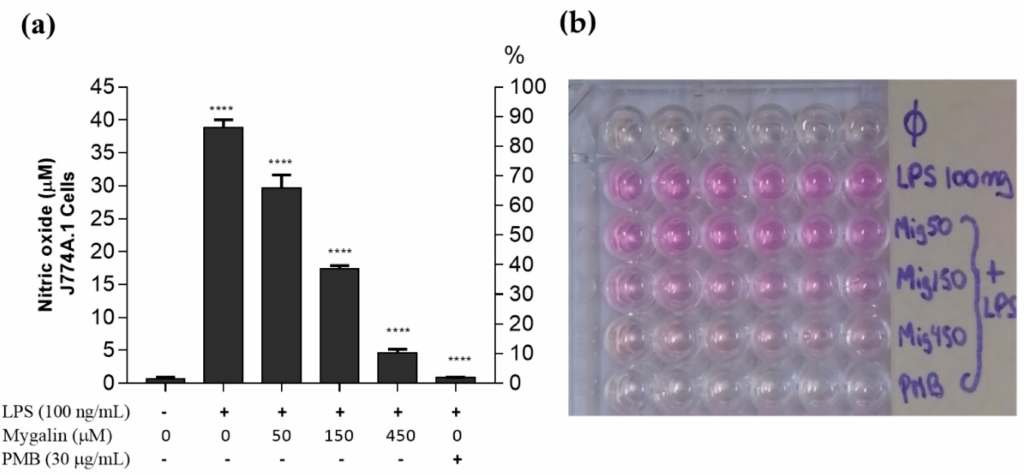
Figure 8. Mygalin neutralizes LPS activity. LPS was incubated with mygalin (50, 150, and 450 µ M) or polymyxin B (PMB, 30 µ g / mL) for 45 min at 37 ◦ C and then added to the J774A.1 macrophage cell culture. ( a ) NO 2 − was quantified at 550 nm after 24 h. ( b ) Visualization of the Griess reaction. The data represent the mean ± SEM of three independent experiments performed in triplicate (**** p < 0.0001 compared to LPS) and ns (not significant) compared to an untreated group.